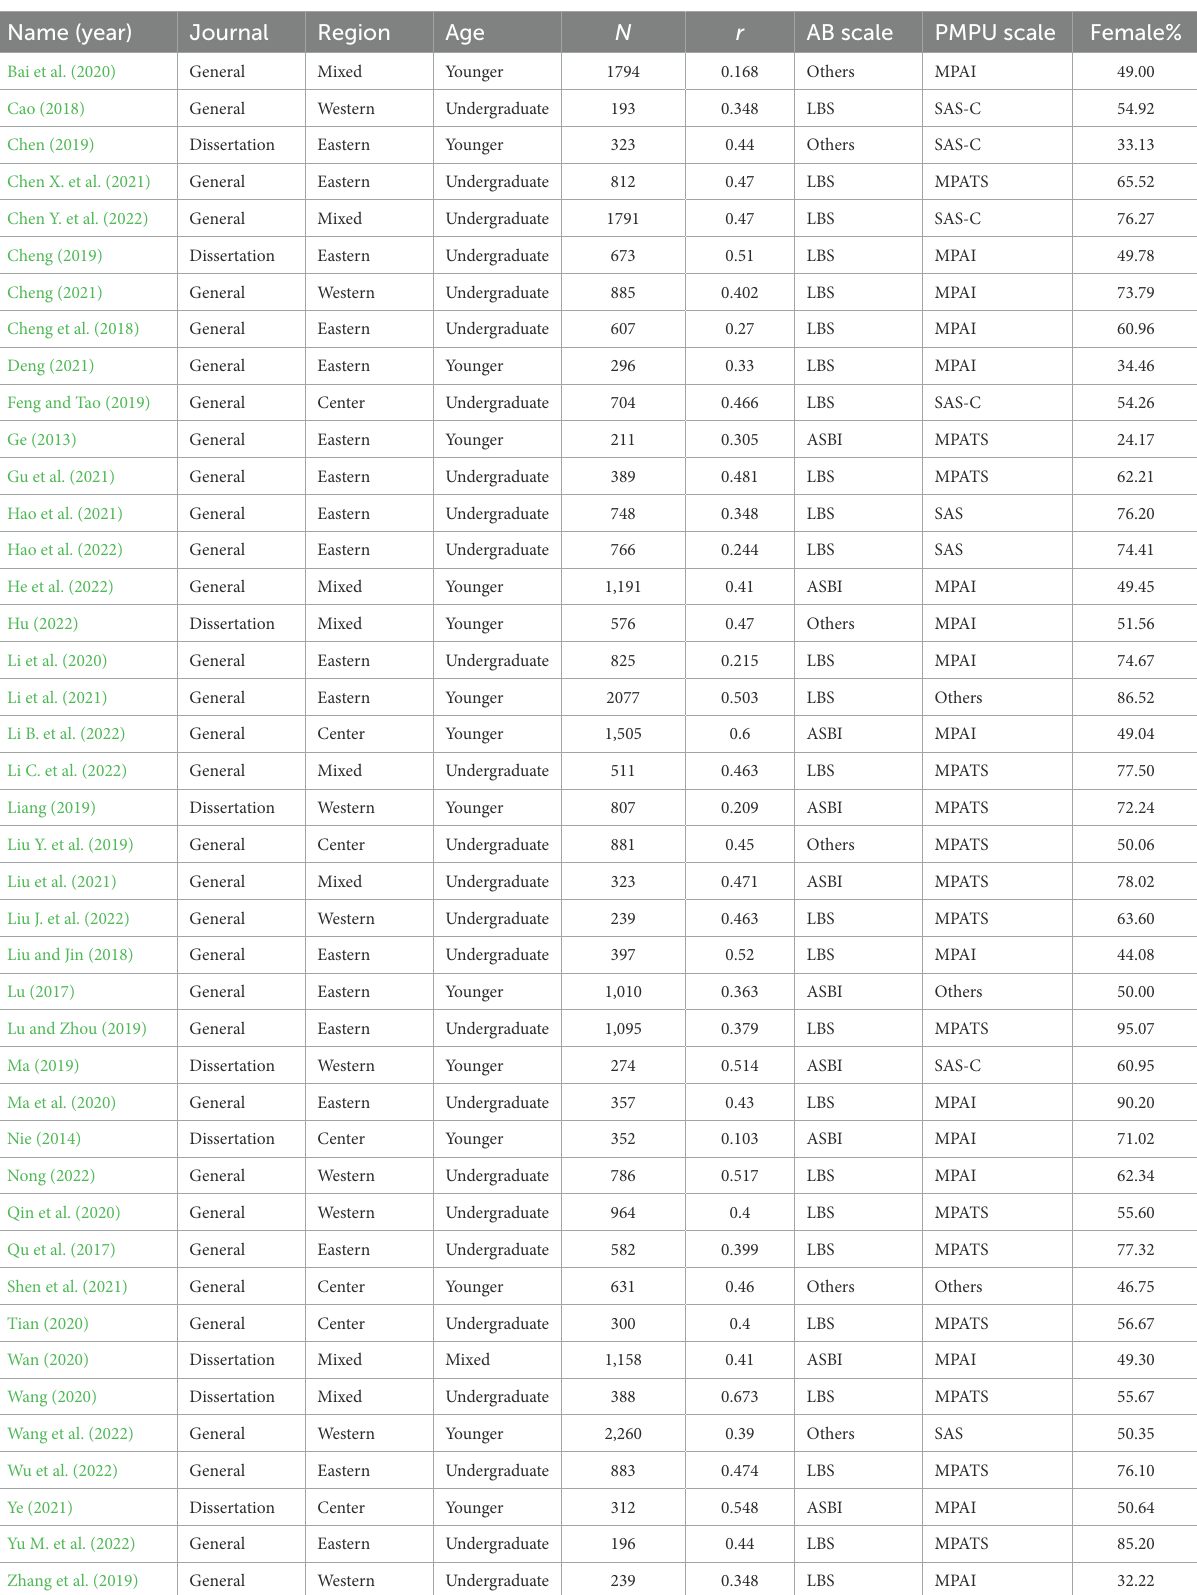
TABLE 1 Characteristics of the 50 studies included in the